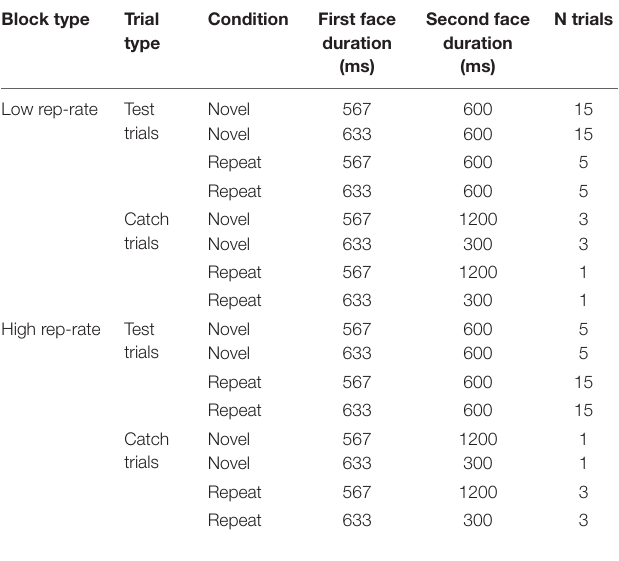
TABLE 1 | The trial